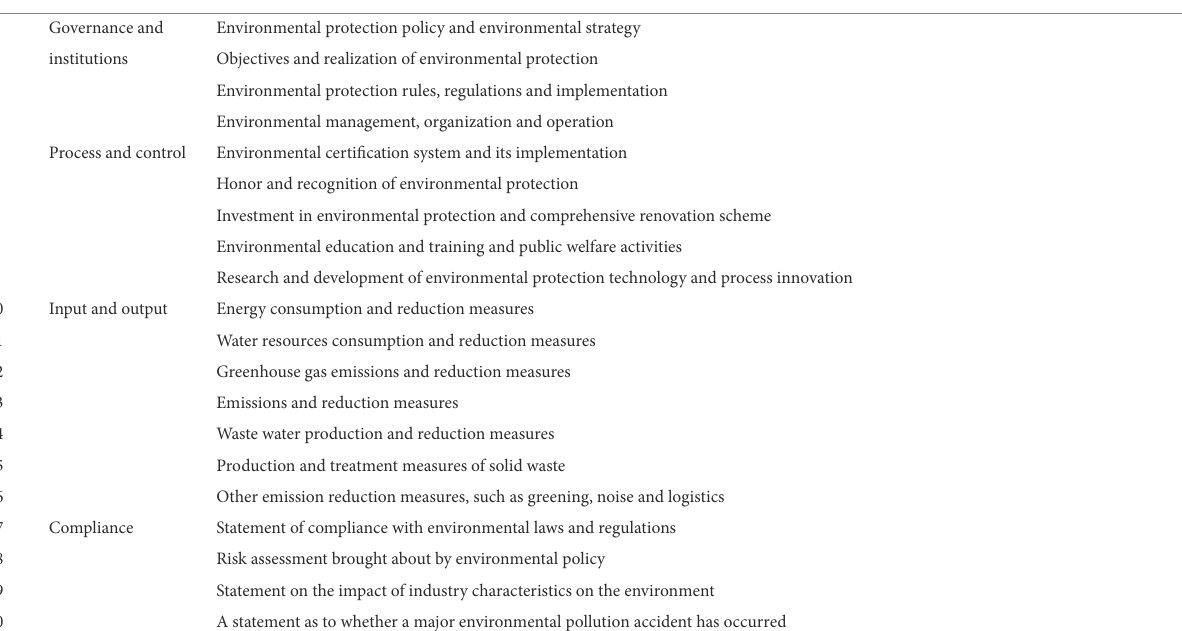
TABLE 7 Greenwashing measurement index